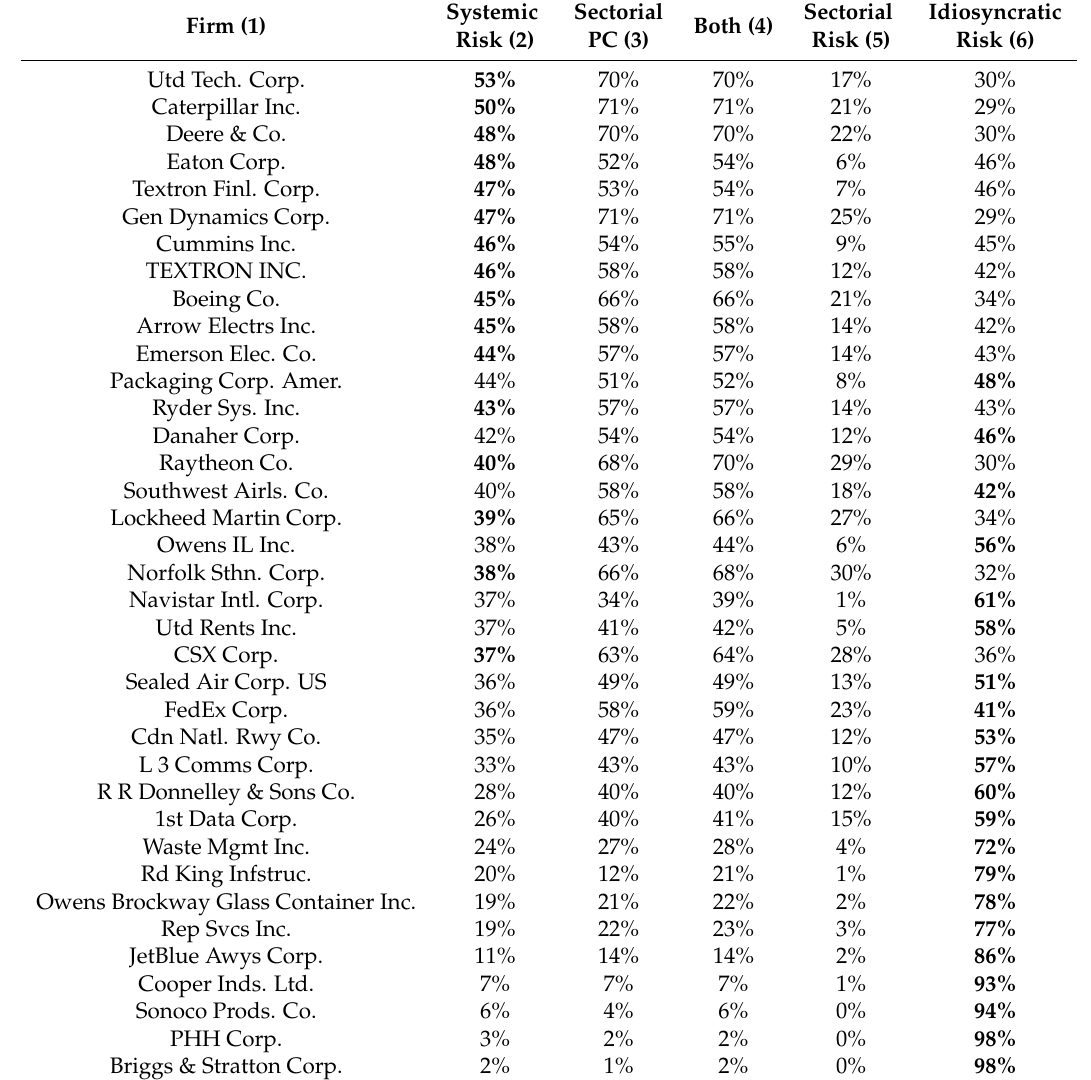
Table 13. Credit risk decomposition for the North American industrial sector. Systemic Sectorial Sectorial Idiosyncratic Firm (1) Both (4) Risk (2) PC (3) Risk (5) Risk (6) Utd Tech. Corp. 53% 70% 70% 17% 30% Caterpillar Inc. 50% 71% 71% 21% 29% Deere & Co. 48% 70% 70% 22% 30% Eaton Corp. 48% 52% 54% 6% 46% Textron Finl. Corp. 47% 53% 54% 7% 46% Gen Dynamics Corp. 47% 71% 71% 25% 29% Cummins Inc. 46% 54% 55% 9% 45% TEXTRON INC. 46% 58% 58% 12% 42% Boeing Co. 45% 66% 66% 21% 34% Arrow Electrs Inc. 45% 58% 58% 14% 42% Emerson Elec. Co. 44% 57% 57% 14% 43% Packaging Corp. Amer. 44% 51% 52% 8% 48% Ryder Sys. Inc. 43% 57% 57% 14% 43% Danaher Corp. 42% 54% 54% 12% 46% Raytheon Co. 40% 68% 70% 29% 30% Southwest Airls. Co. 40% 58% 58% 18% 42% Lockheed Martin Corp. 39% 65% 66% 27% 34% Owens IL Inc. 38% 43% 44% 6% 56% Norfolk Sthn. Corp. 38% 66% 68% 30% 32% Navistar Intl. Corp. 37% 34% 39% 1% 61% Utd Rents Inc. 37% 41% 42% 5% 58% CSX Corp. 37% 63% 64% 28% 36% Sealed Air Corp. US 36% 49% 49% 13% 51% FedEx Corp. 36% 58% 59% 23% 41% Cdn Natl. Rwy Co. 35% 47% 47% 12% 53% 33% 43% 43% 10% 57% 28% 40% 40% 12% 60% 26% 40% 41% 15% 59% 24% 27% 28% 20% 21% 1% 79%